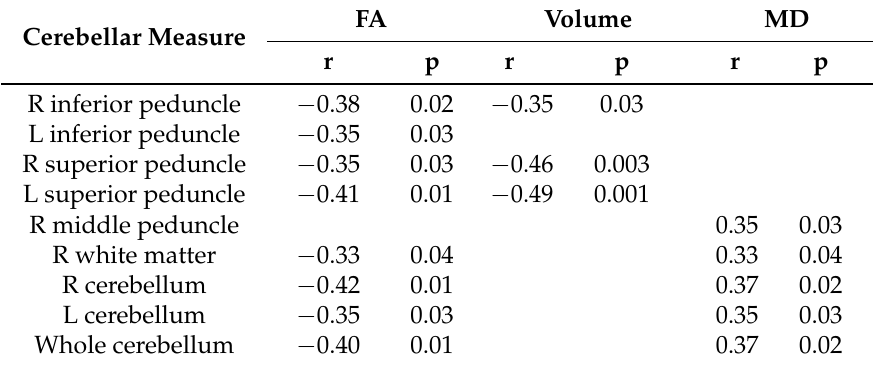
Table 4. Spearman Correlations of Cerebellar Measures with NIH NPC Severity Score (NNSS). FA Volume Cerebellar Measure